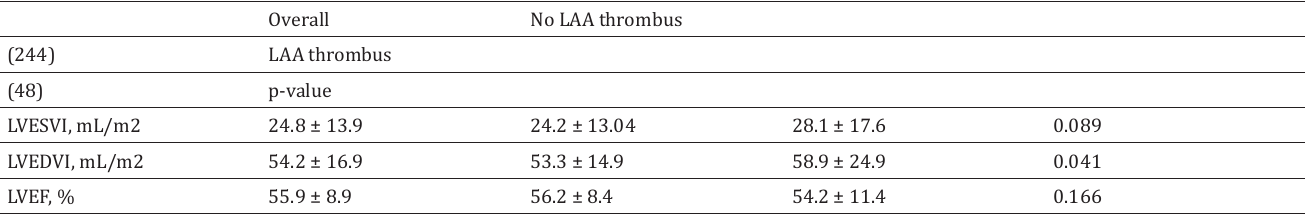
Comparison of volume measurements between patients with and without LAA thrombus according to transesophageal echocardiography (N=292)